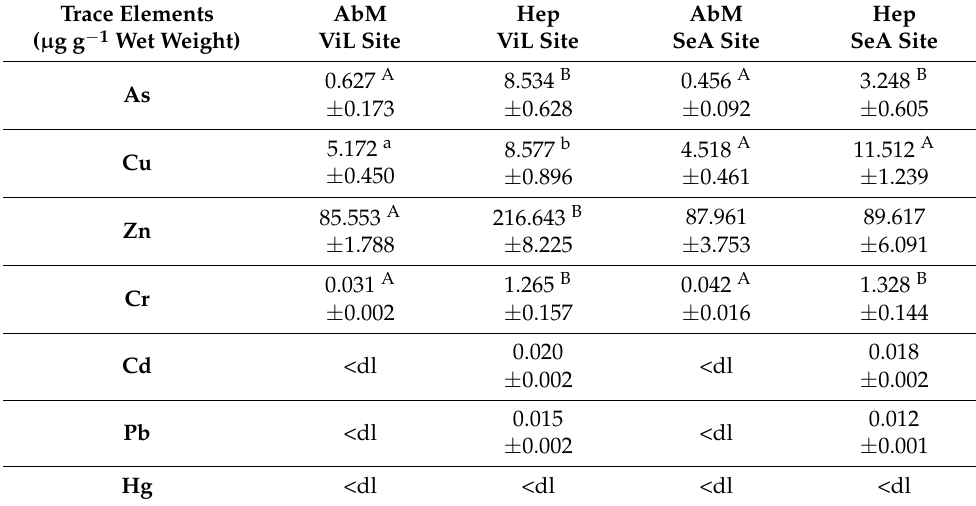
Table 2. Mean concentration ( µ g g − 1 wet weigth) ± SEM of trace elements (As, Cu, Zn, Cr, Cd, Pb and Hg) in Procambarus clarki abdominal muscle (AbM) and hepatopancreas (Hep) from Villa Literno (ViL) and Sessa Aurunca